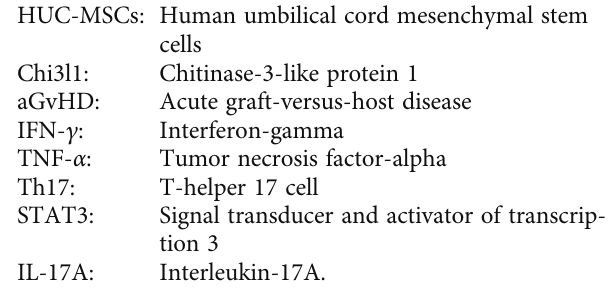
Supplementary 1 . Table S1: the DEGs of four MSCs. Supplementary 2 . Figure S1: control (NC) lentivirus transfec- tion of